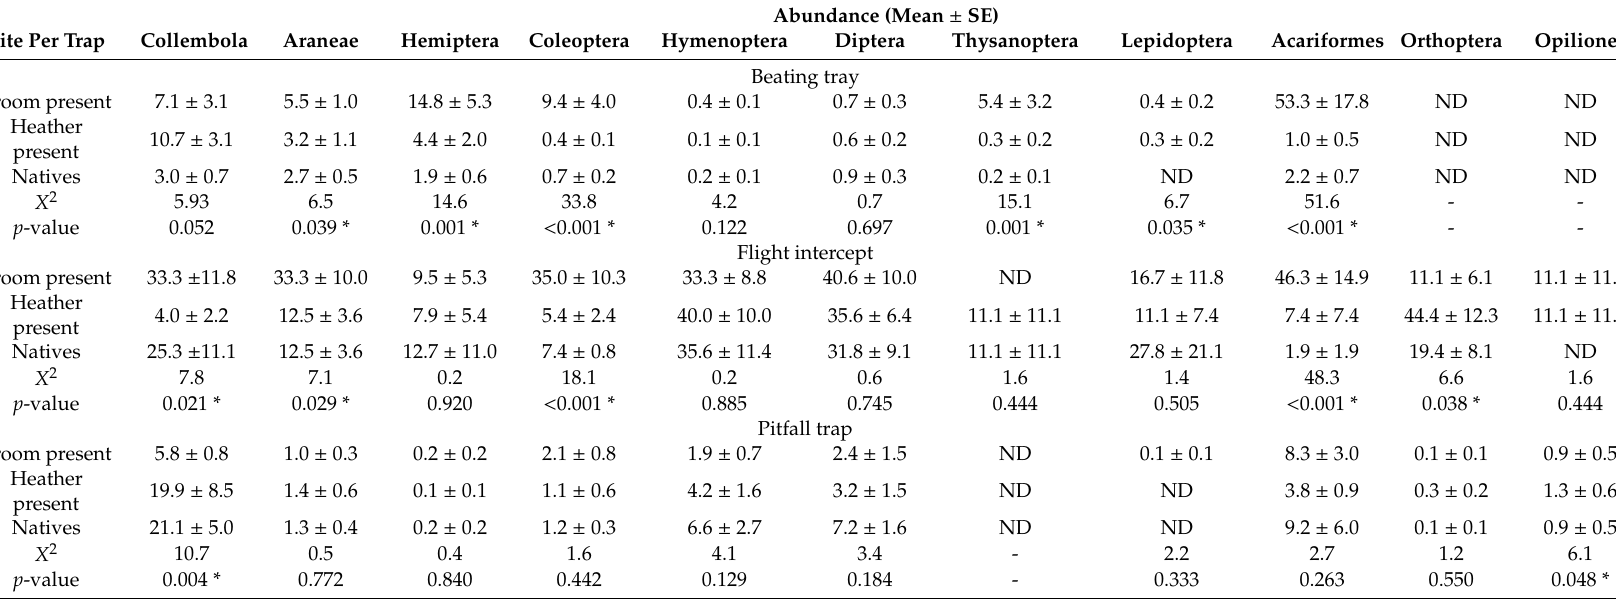
Table 2. The most abundant arthropod orders found at weed-invaded and non-invaded sites in autumn. Comparisons between sites were performed using a negative binomial generalised linear model. Site was the predictor, while arthropod groups were used as the response variables. The likelihood ratio test was used to assess the significance of the predictors.